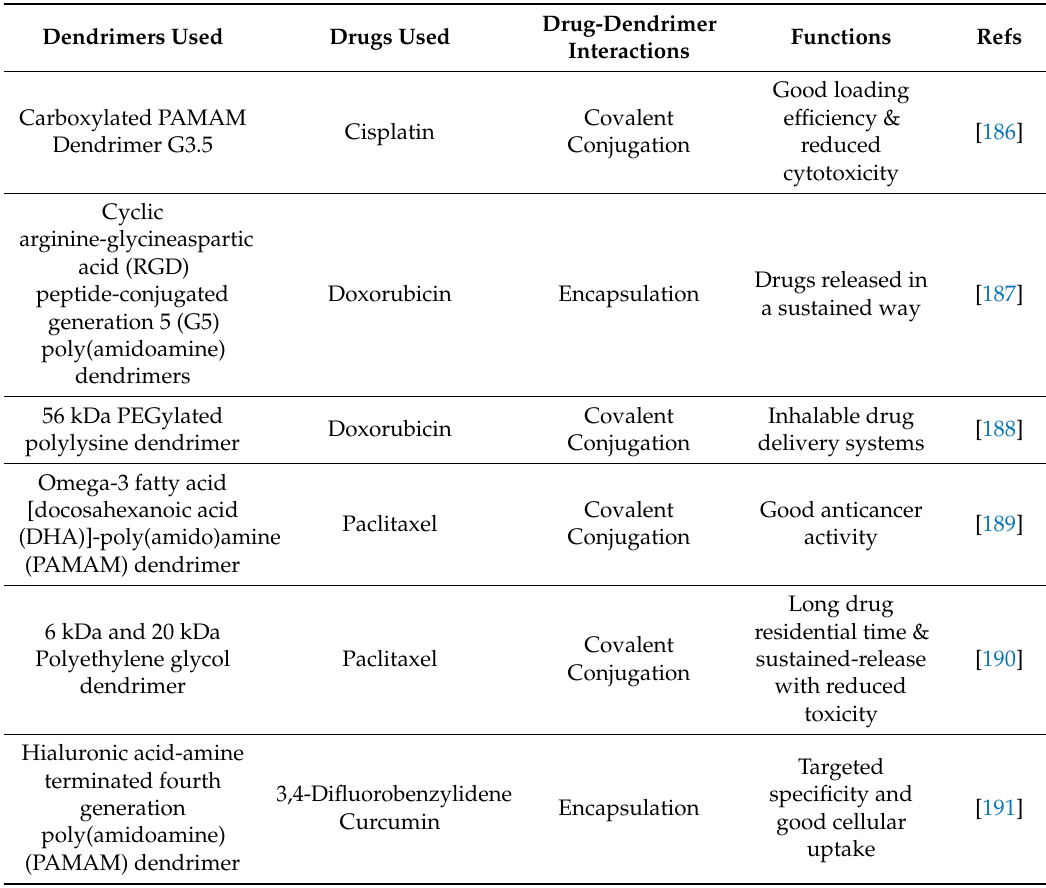
Table 5. The dendrimers and drugs interactions in cancer